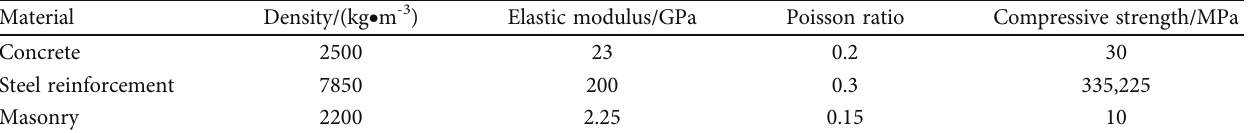
Table 1: Material physical